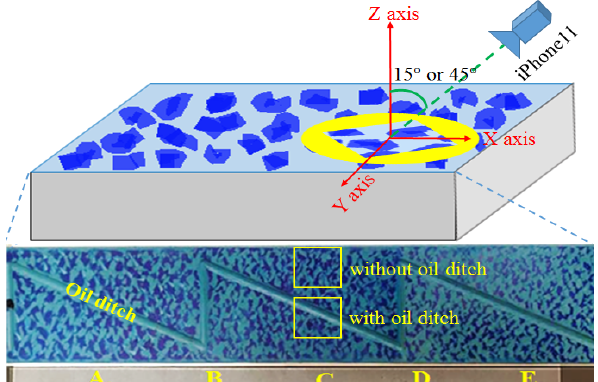
Figure 13. The environment setting for evaluating repeatability of POP and PPI on 5 different densities of HOP regions in the same piece of scraping workpiece. Table 3. Evaluation of POP and PPI repeatability on 5 different densities of HOP regions.